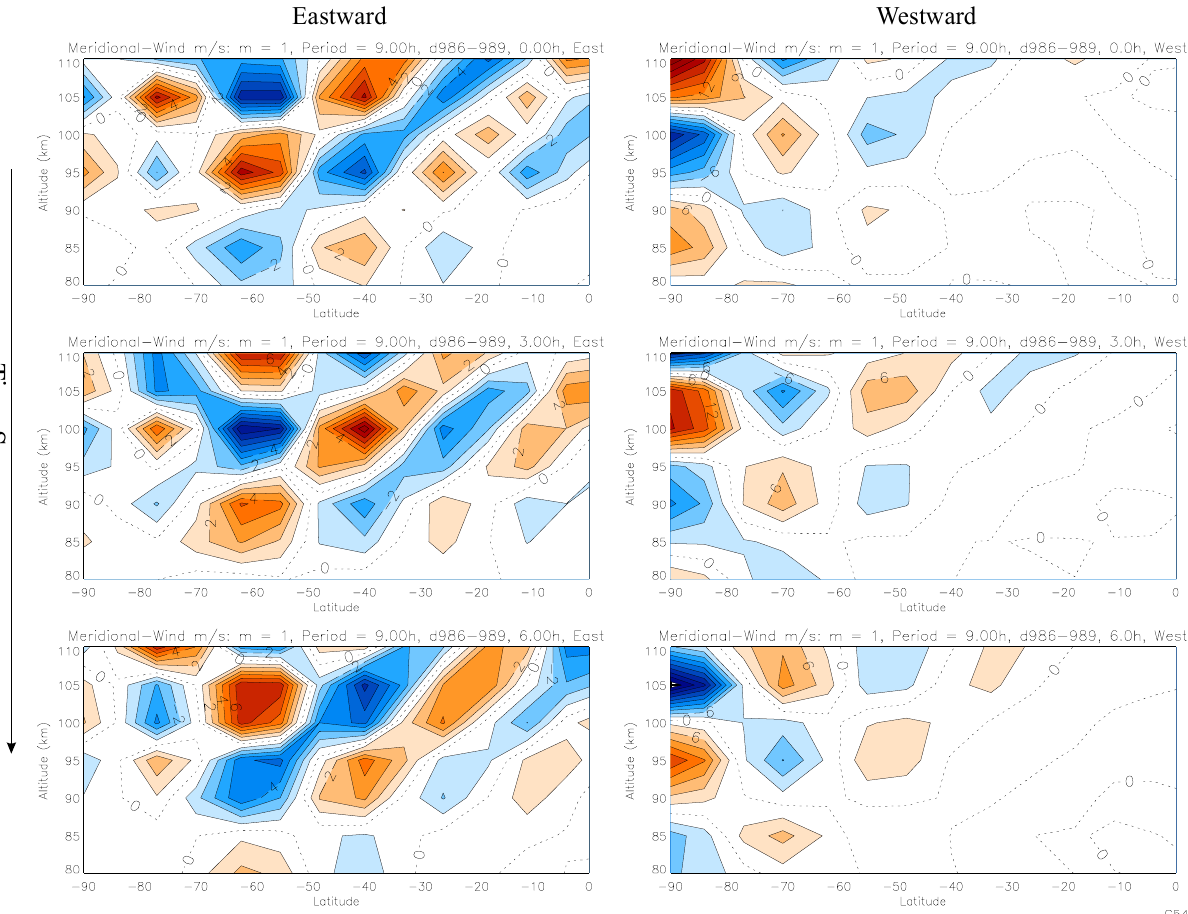
Fig. 7. Snapshots of the meridional winds in the Southern Hemisphere near 32.5 months (mid September), when waves are most prominent. The winds are derived from 3-day time spans to describe the 9-h westward and eastward propagating waves. Plotted with 3-h time intervals, the phase of the waves is shown progressing downwards. (Since the numerical results are recorded with 5-km increments, the contours appear